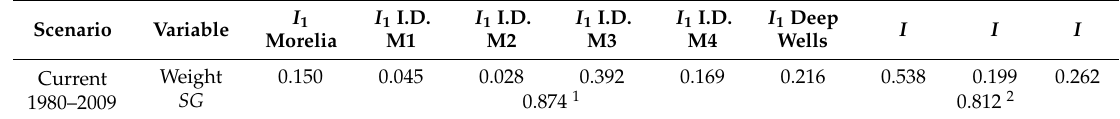
Table 4. Weights and sustainability by groups SG 1 and SG 2 for the current scenario.